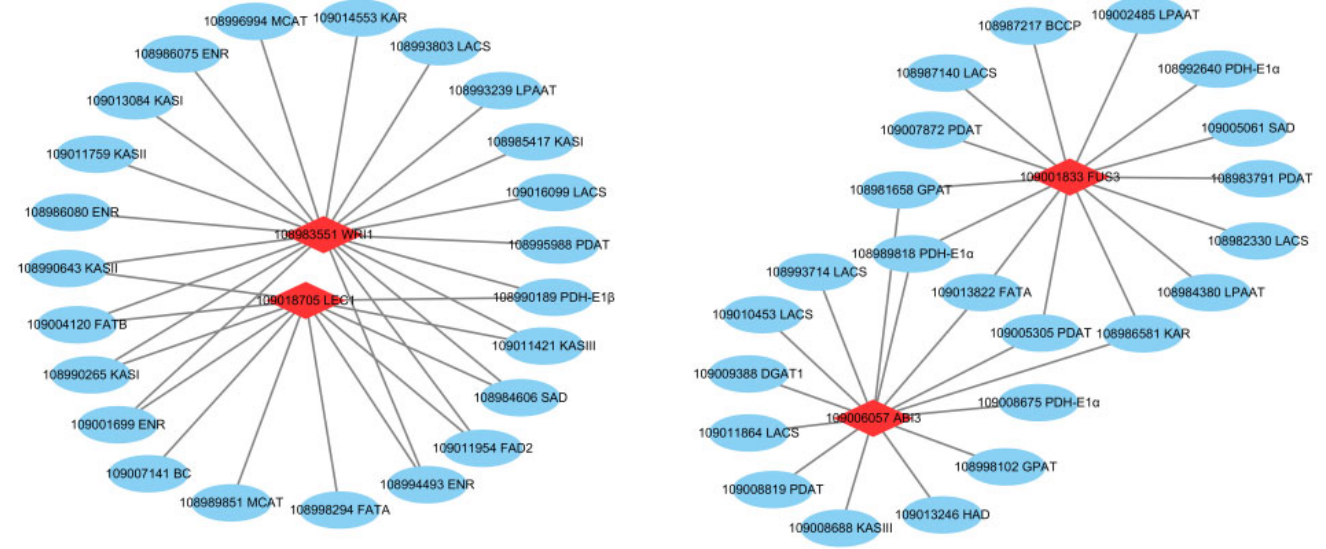
Figure 8. Connection network between lipid synthesis-related transcription factors (red rhombus) and structural genes (blue circle). The correlation coefficients were greater than 0.9, both with the TFs and structural genes. The gray line indicates a positive correlation.